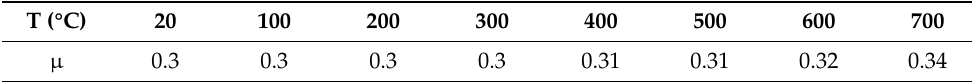
Table 3. GH4169 alloy Poisson (cid:48) s